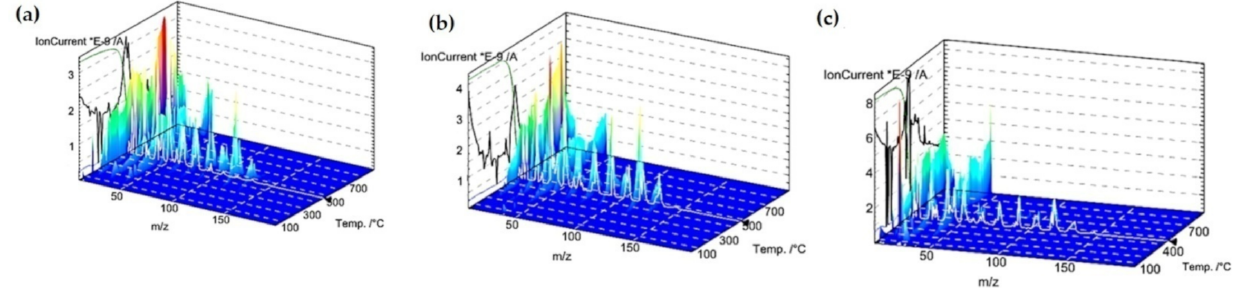
Figure 15. 3D MS profiles registered during decomposition of DVB:TEVS = 1:1 after adsorption of P ( a ), 4-NP ( b ) and NB ( c ).